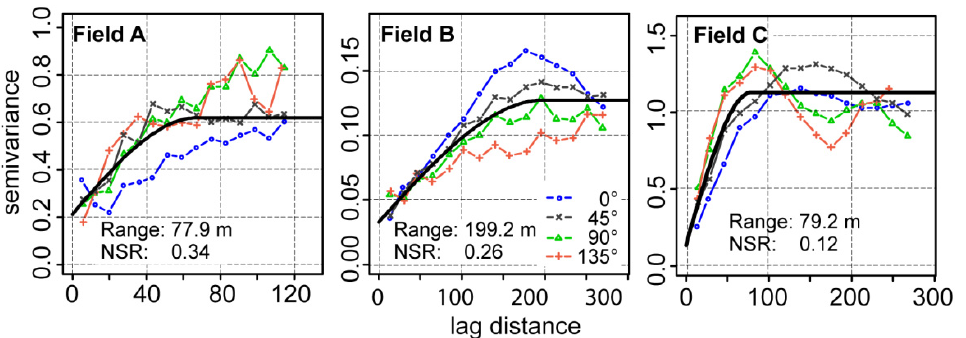
Figure 9. Directional experimental semivariograms of the calibrated on-the-go pH measurements computed in four different directions. The 0° indicates the direction along the measurement track. The black line denotes the omnidirectional semivariogram